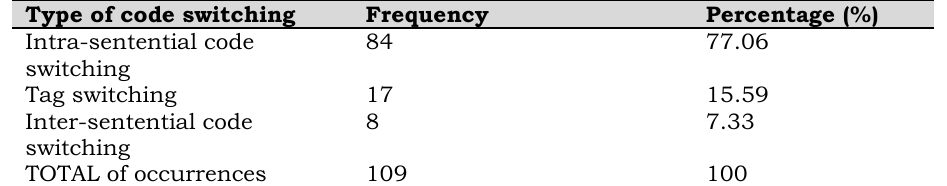
Table 1: Percentage of types of code switching used by the student and lectures in an EFL thesis defense examination